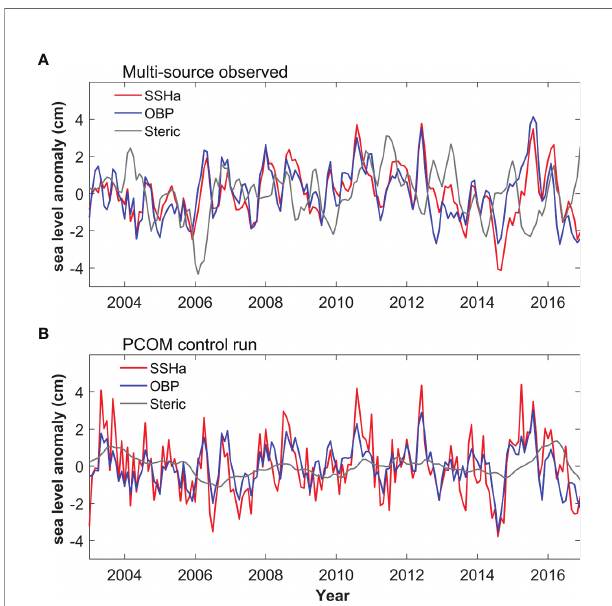
FIGURE 13 | (A) The time series of sea surface height, OBP, steric sea level anomalies averaged in eastern southern Indian Ocean (45°-60°S, 80°-120°E, box in Figure 1A ) derived from observations. (B) is same as (A) but for PCOM control interannual time scales ( Figure 13 ). The correlation coef fi cient between observed sea level anomaly and OBP anomaly is 0.79 (signi fi cant at the 95% con fi dence level). Very good coherence also exists between them in the PCOM. Therefore, the study of OBP also can improve the understanding of the dynamics of sea level variations in Southern Indian Ocean.